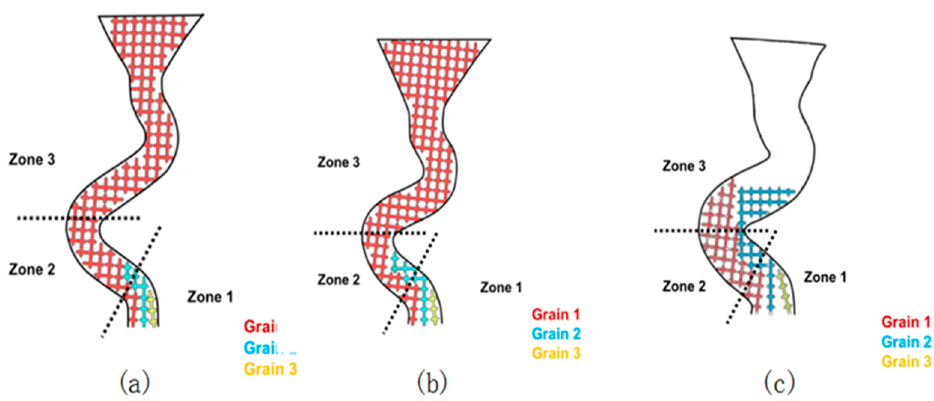
Figure 7. Grains (1, 2, and 3) growth and selecting in grain selectors varying in diameter: ( a ) 2.6 mm, ( b ) 3 mm, and ( c ) 6 mm.